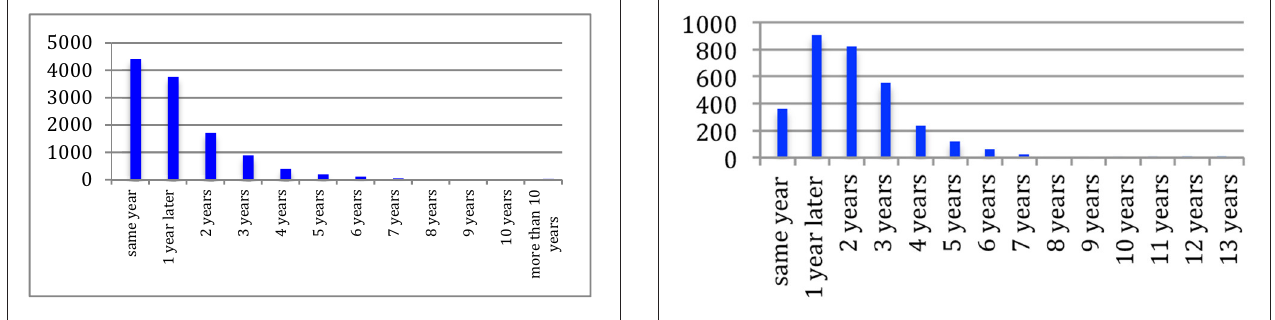
FIGURE 31 | Time delay between publication and reuse.